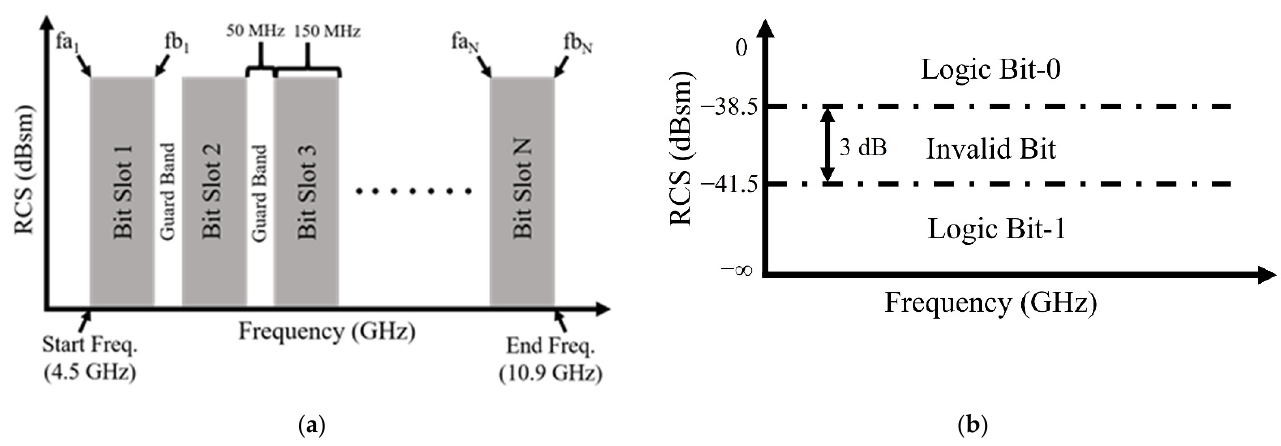
Figure 2. ( a ) Spectral allocation for the proposed tag; ( b ) RCS magnitude allocation for the pro- posed tag.